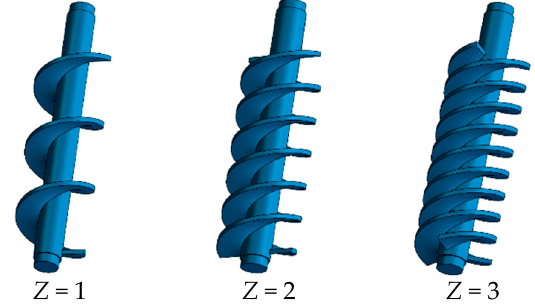
Figure 4. Screw shaft with different number of heads.